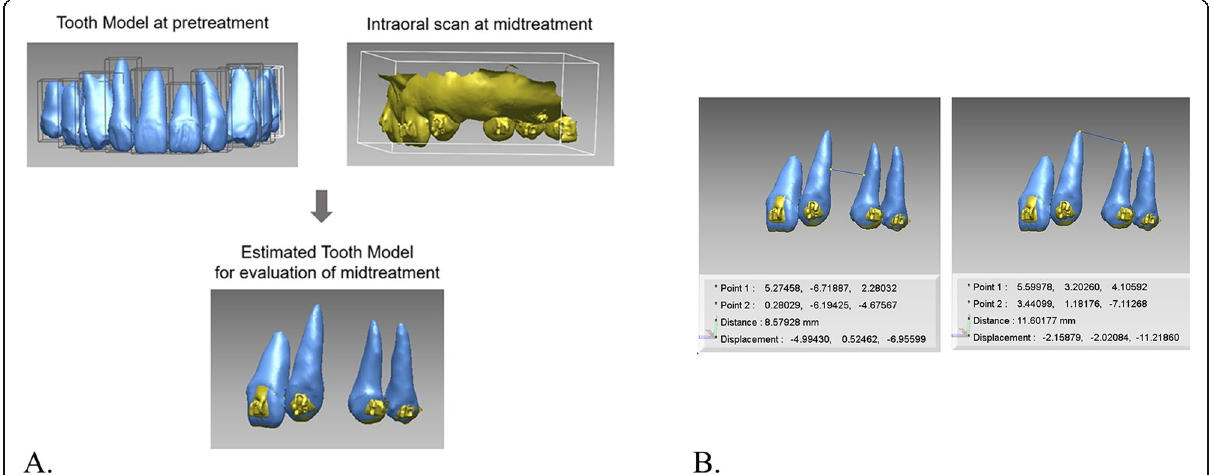
Fig. 4 Generation of a tooth model with expected root position using the tooth model at pretreatment and intraoral scan at mid-treatment. a Intraoral scan at mid-treatment was registered onto the individual tooth model at pretreatment. b On the software program, the measured inter- root distance was 8.6 mm at the mid-root and 11.6 mm at the apex